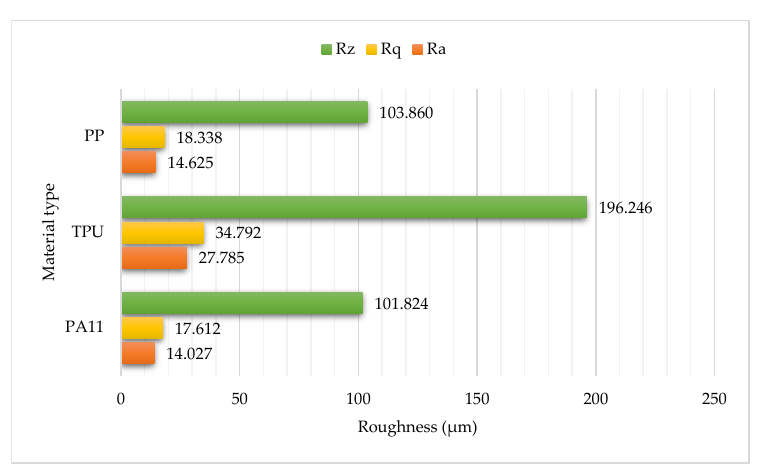
Figure 9. The average surface roughness of the samples grouped by material. On the next plot, shown in Figure 10, the standard deviations for the three computed roughness parameters have been presented in order to see how much, on average, the results diverge from the determined mean values.